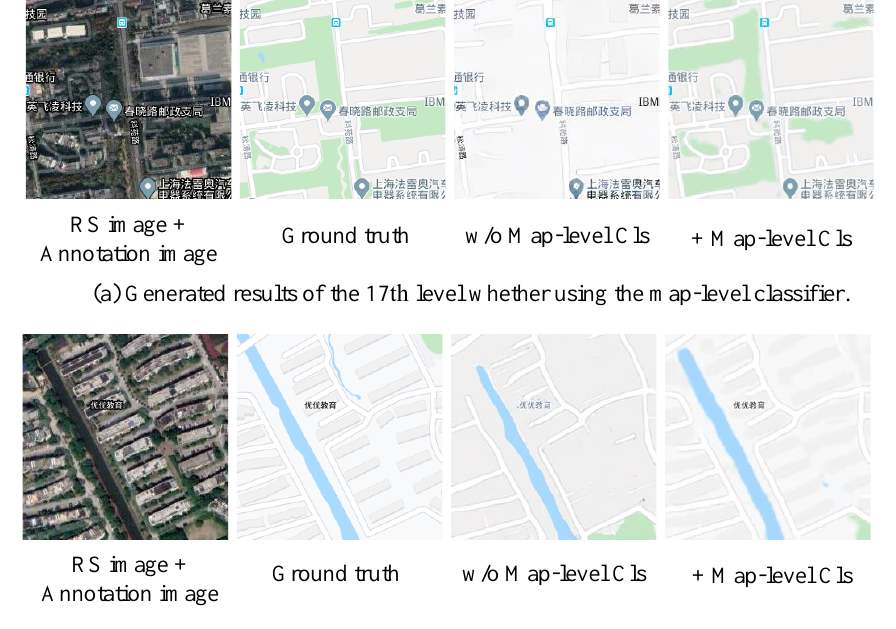
Figure 12. The comparison of generation results with the use of the map-level classifier and without the use of the map level classifier.